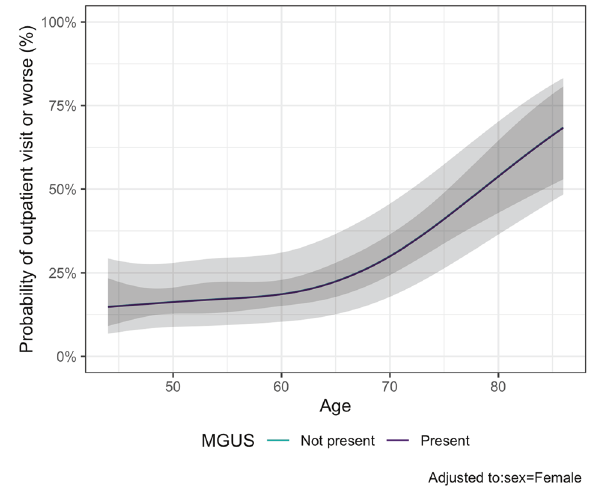
Fig. 3 Probability of severe COVID-19. Probability of individuals with or without MGUS having severe COVID-19 according to age, adjusted to female sex. Severe COVID-19 is de fi ned as the composite outcome of emergency outpatient visits, hospital admission, or